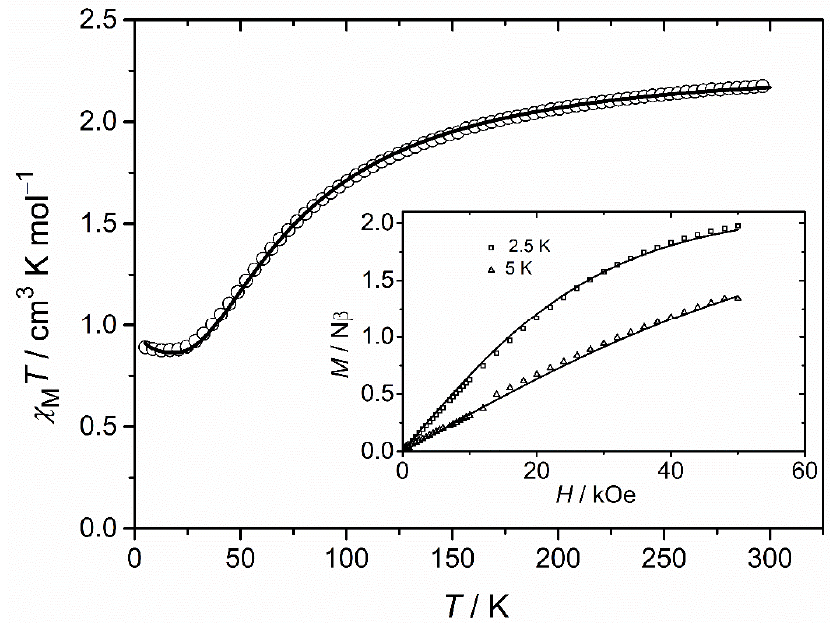
Figure 5. χ M T versus T curve for 1 (H = 0.5 kOe). Inset: M versus H curves measured at 2.5 and 5 K. The solid lines represent the best-fit curves (see text).